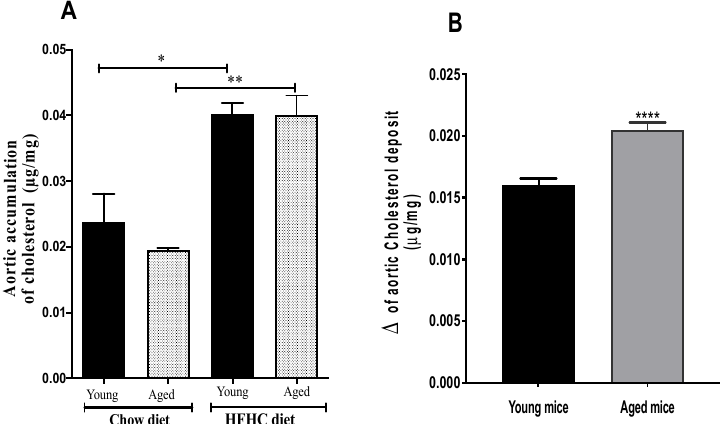
Figure 2. An HFHC diet increases the accumulation of cholesterol in the aorta. ( A ) Cholesterol levels in the aortas of young and aged mice fed an HFHC diet for 12 weeks compared to cholesterol levels in the aortas of young and aged mice fed chow for 12 weeks. ( B ) Difference in the cholesterol levels of the aortas of the young and aged mice fed an HFHC diet for 12 weeks. Data are expressed as means ± SEM ( n =5 mice/group). * p < 0.05, ** p < 0.01, **** p < 0.0001 versus chow.